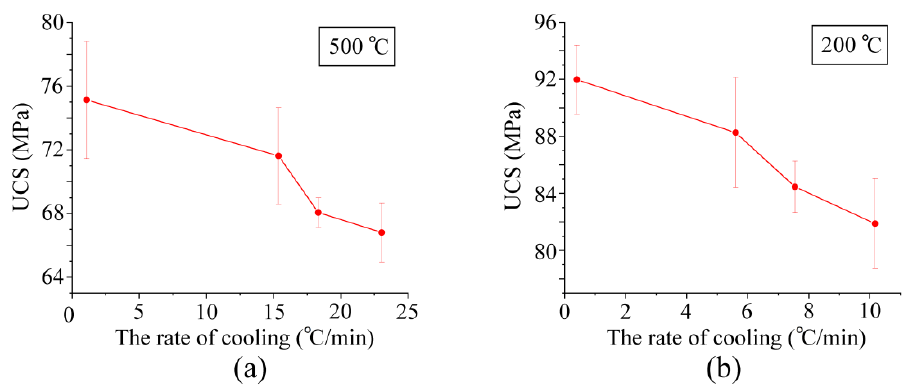
Figure 8. Variation of uniaxial compressive strength versus cooling rates: ( a ) after heating at 500 °C; ( b ) after heating at 200 °C (Error bars denote standard deviation).